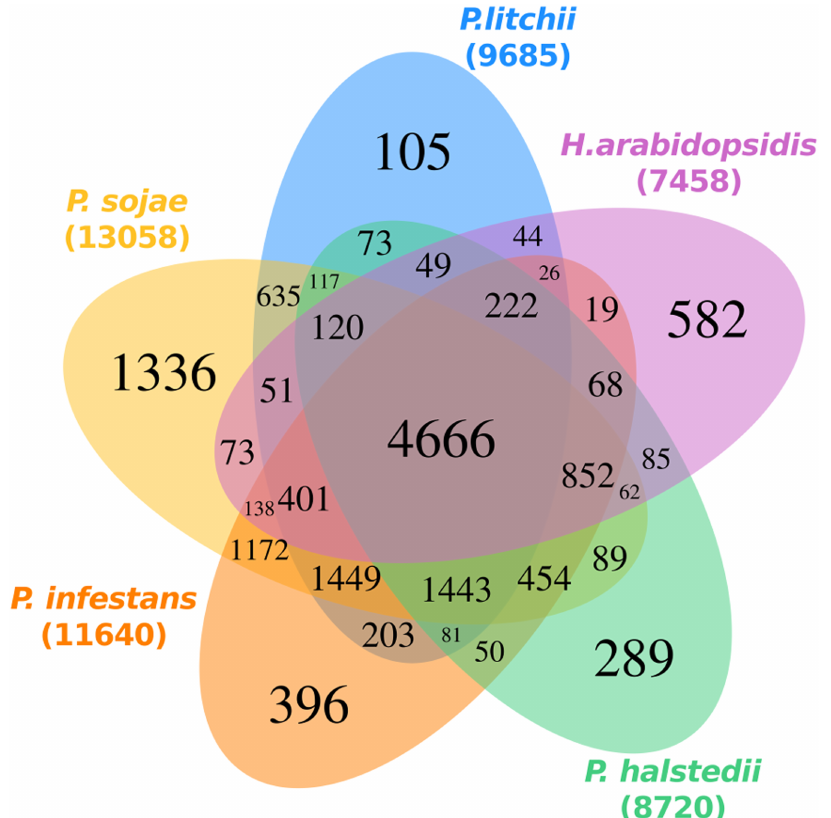
Fig 1. Five-way-Venn-diagram of unique and shared gene families among oomycete species. Homologous proteins in P . litchii , H . arabidopsidis , P . halstedii , P . infestans , and P . sojae were clusteredinto gene families using OrthoMCL. Numbers in each section refer to numberof gene families (not genes). Overlapping regionsdenote groups with at least one protein of all species that are part of the intersection. The numberunder the organismname refer to the total number of